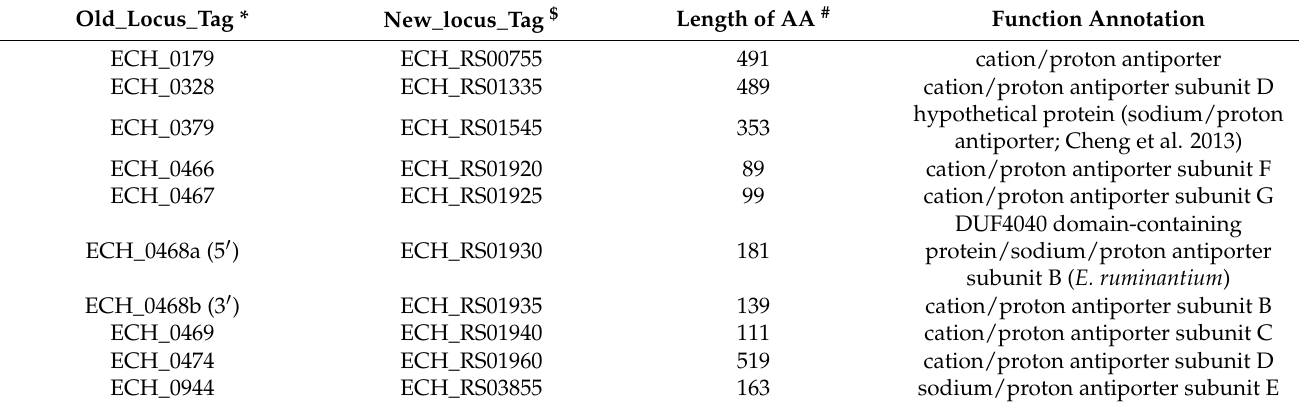
Table 1. Putative antiporters in E. chaffeensis